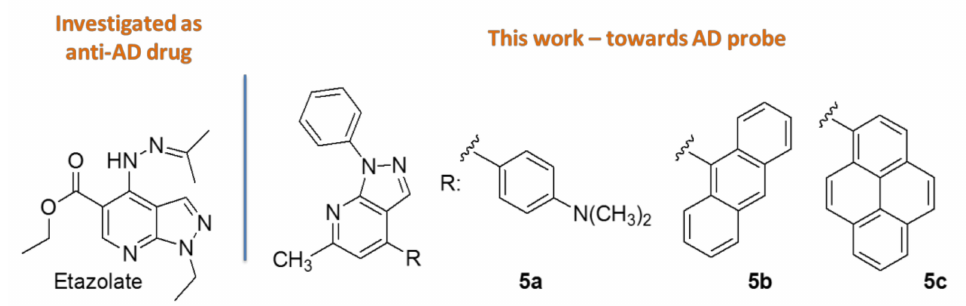
Figure 2. The structures of pyrazolo[3,4- b ]pyridines Etazolate and the target compounds of this